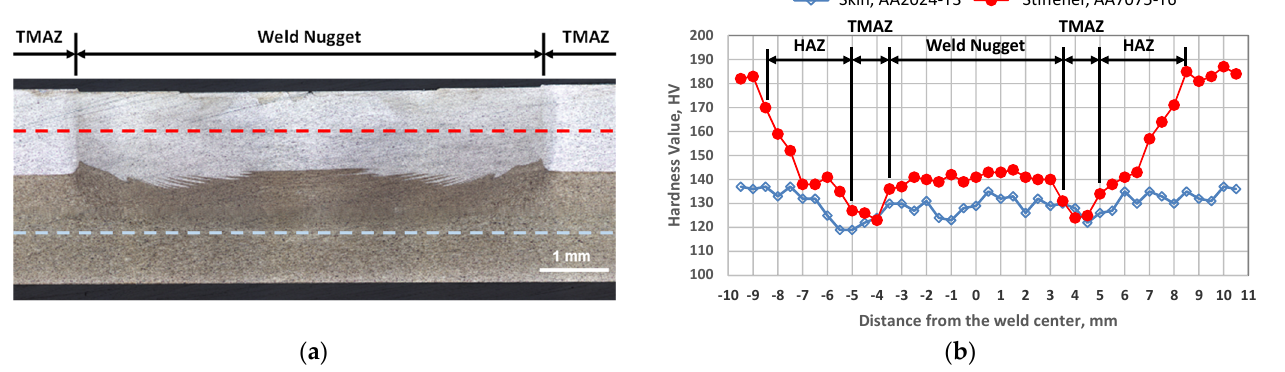
Figure 13. Refill spot weld regions: ( a ) refill spot weld cross-section image and ( b ) refill spot weld cross-section micro- hardness map. The stiffener piece is a 1.27-mm-thick AA7075-T6 sheet, which has a lighter color in the weld cross-section image. The skin piece is a 1.6-mm-thick AA2024-T3 sheet, which has a darker color in the weld cross-section image. The welding process was performed on the stiffener side. The microhardness measurements are the Vickers hardness values sampled along the midplane lines of the stiffener sheet and the skin sheet of the weld cross-section specimen. The hardness measurement lines are indicated by the perforated lines in the weld cross-section image ( a ). The nominal Vickers hardness values of AA7075-T6 and AA2024-T3 are ~183 HV and ~135 HV, respectively.